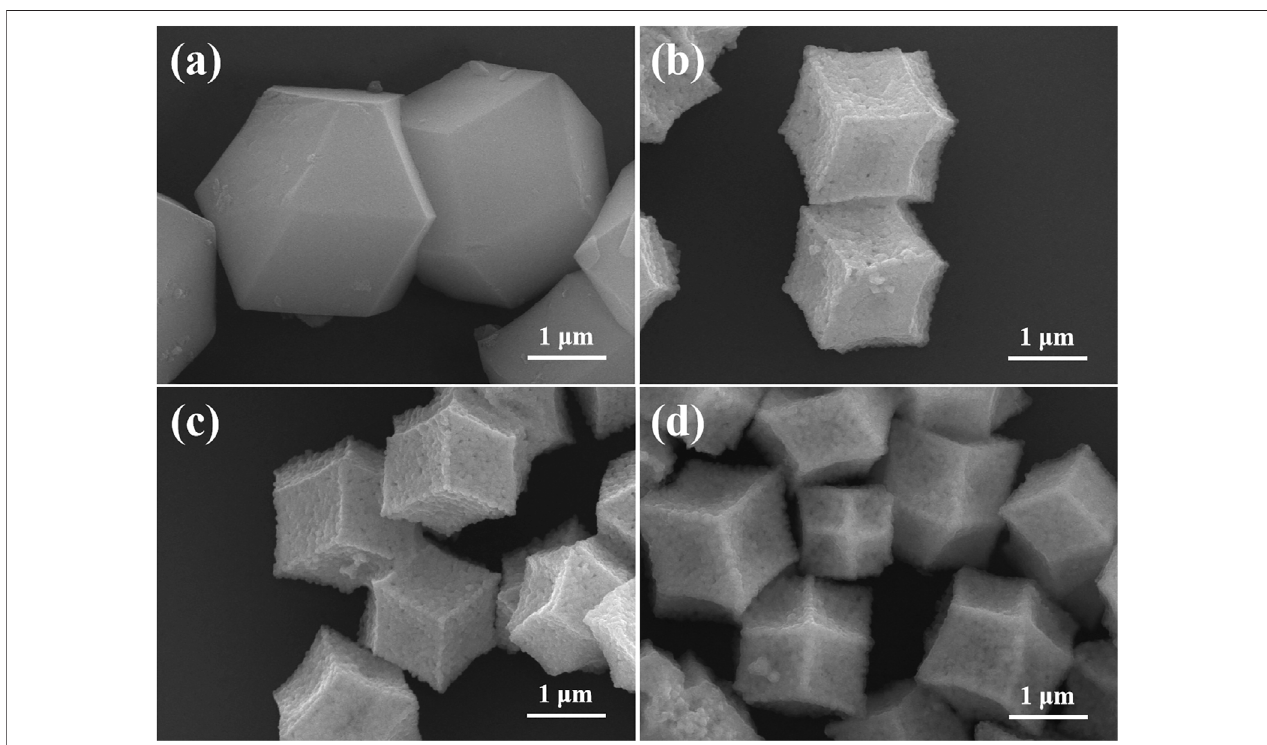
FIGURE 2 | SEM images of (A) ZIF-8, (B) ZnO, (C) Ag/ZnO, (D) Ag/ZnO@N-carbon.